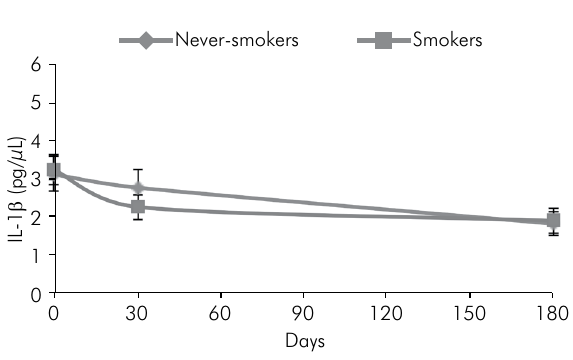
Figure 1. Means (with standard-error bars) of IL-1 β concentration over the study period by smoking status and experimental site. There were no significant differences between never-smokers and smokers.